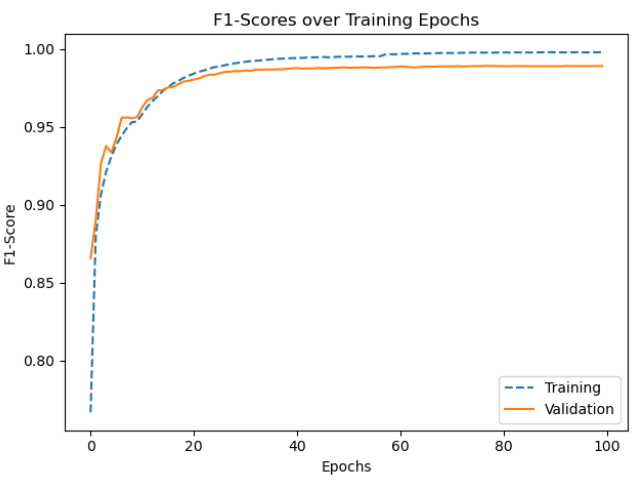
Figure 7. The progress of the score for the final training for 100 epochs. The progress shows an asymptotic behavior after around about 40